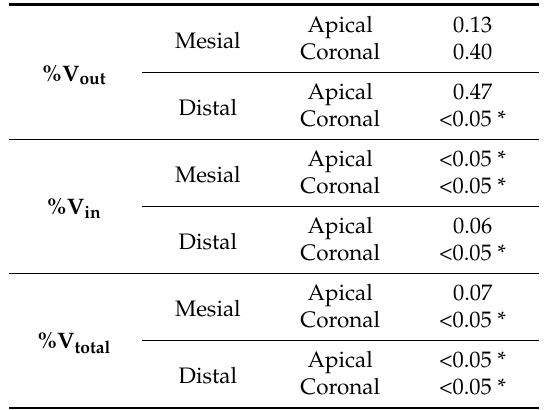
Table 3. Post hoc p -values of the